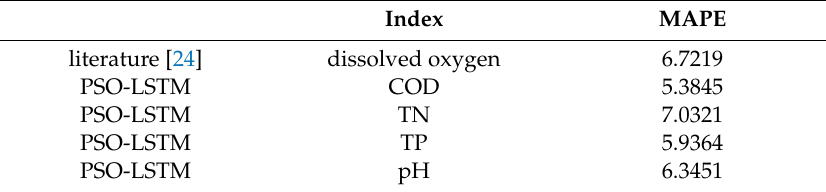
in Table 8. As indicated in Table 8, the PSO-LSTM model used in this paper generally has a smaller MAPE value, which indicates a good performance at predicting water quality time series. Table 8. Accuracy of the water quality time series prediction